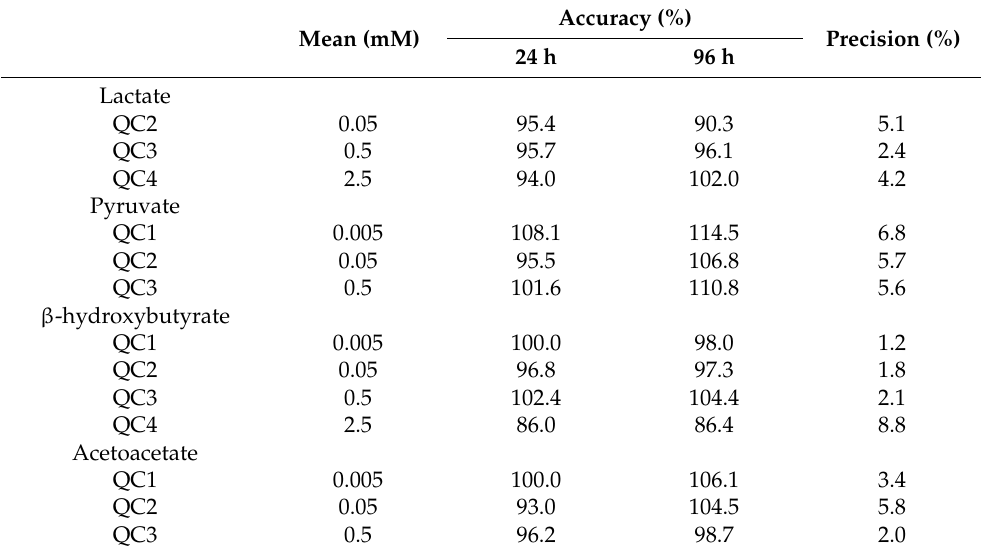
Table 6. Stability in the autosampler at ambient temperature expressed as accuracy values of quality control samples after 24 h and 96 h. QC: quality